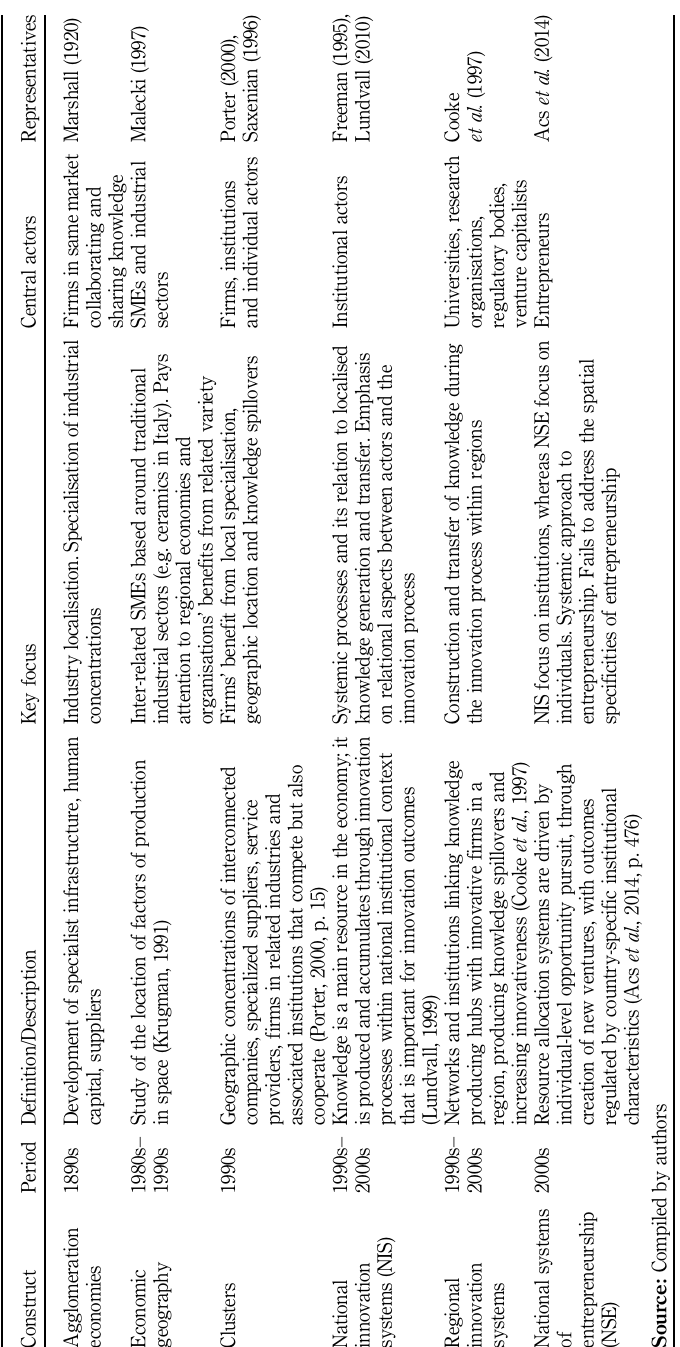
Table I. Related constructs